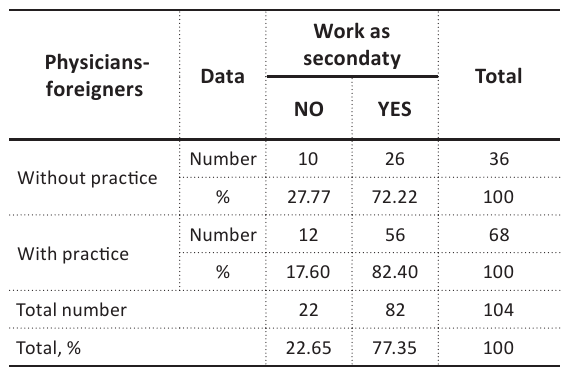
Table 3. Physicians-foreigners according to the